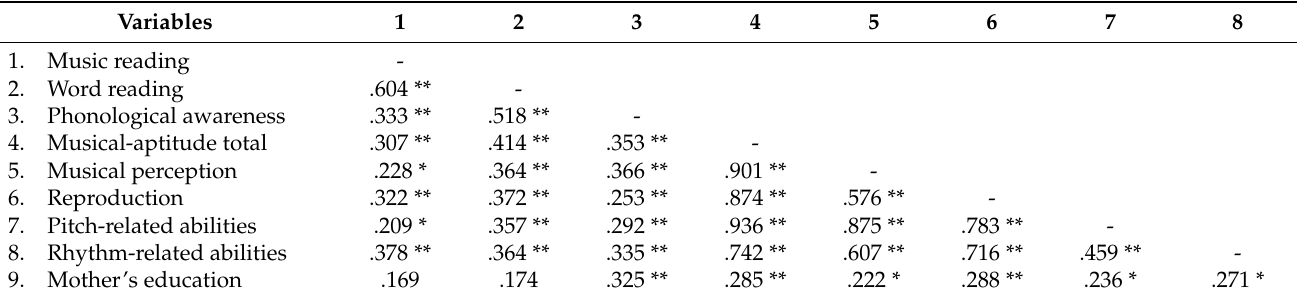
Table 2. Intercorrelations of the